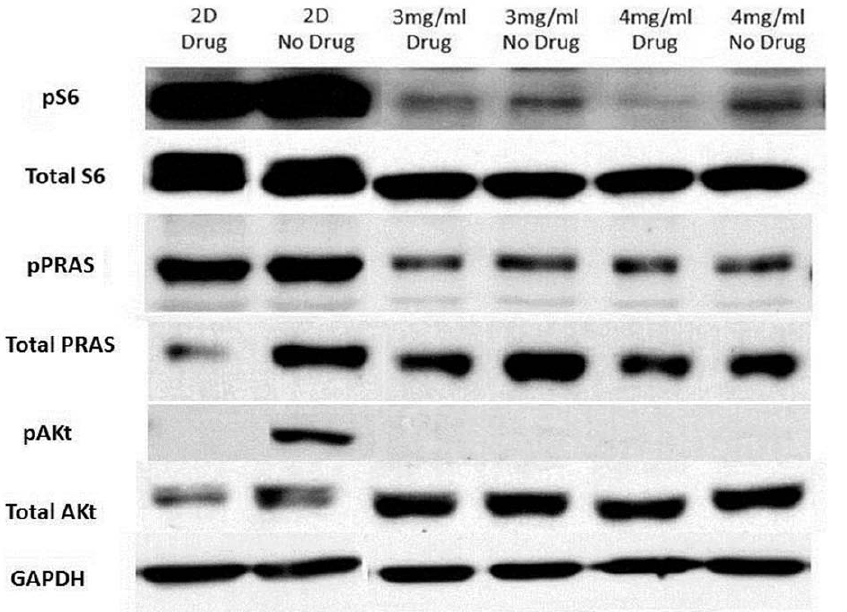
Figure 11. Western Blots for protein S6, PRAS, Akt and GAPDH in U2OS cells on different substrates with and without drug treatment. Cells were plated, and then harvested 24 hours later. Cell lysates were kept at 2 80 u C if not immediately used. Drug treatment reduced levels of pS6 in all samples, consistent with the observed increase in cell doubling time. Paradoxically, this reduction was most pronounced in cells grown in 4 mg/ml despite these cells showing the highest proliferative resistance to the effects of PI103.